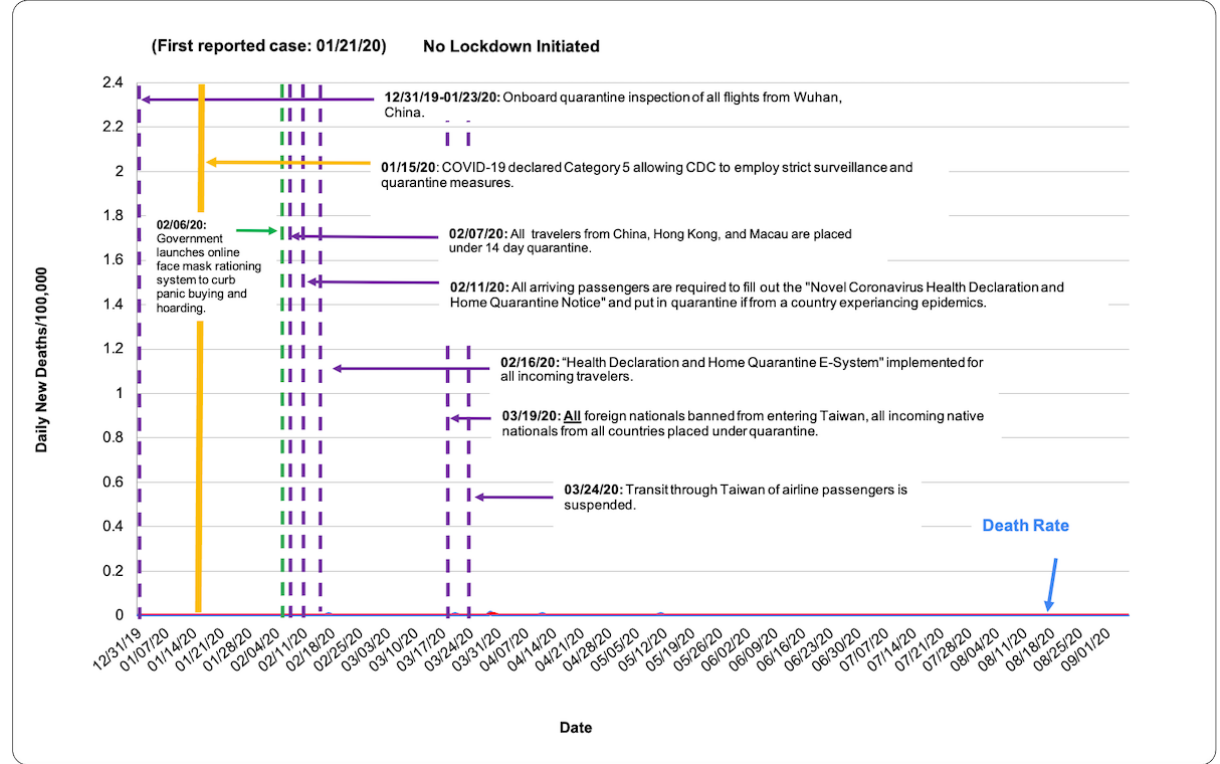
Figure 2. Daily new deaths per 100,000 people for Taiwan from December 31, 2019, to September 6, 2020.